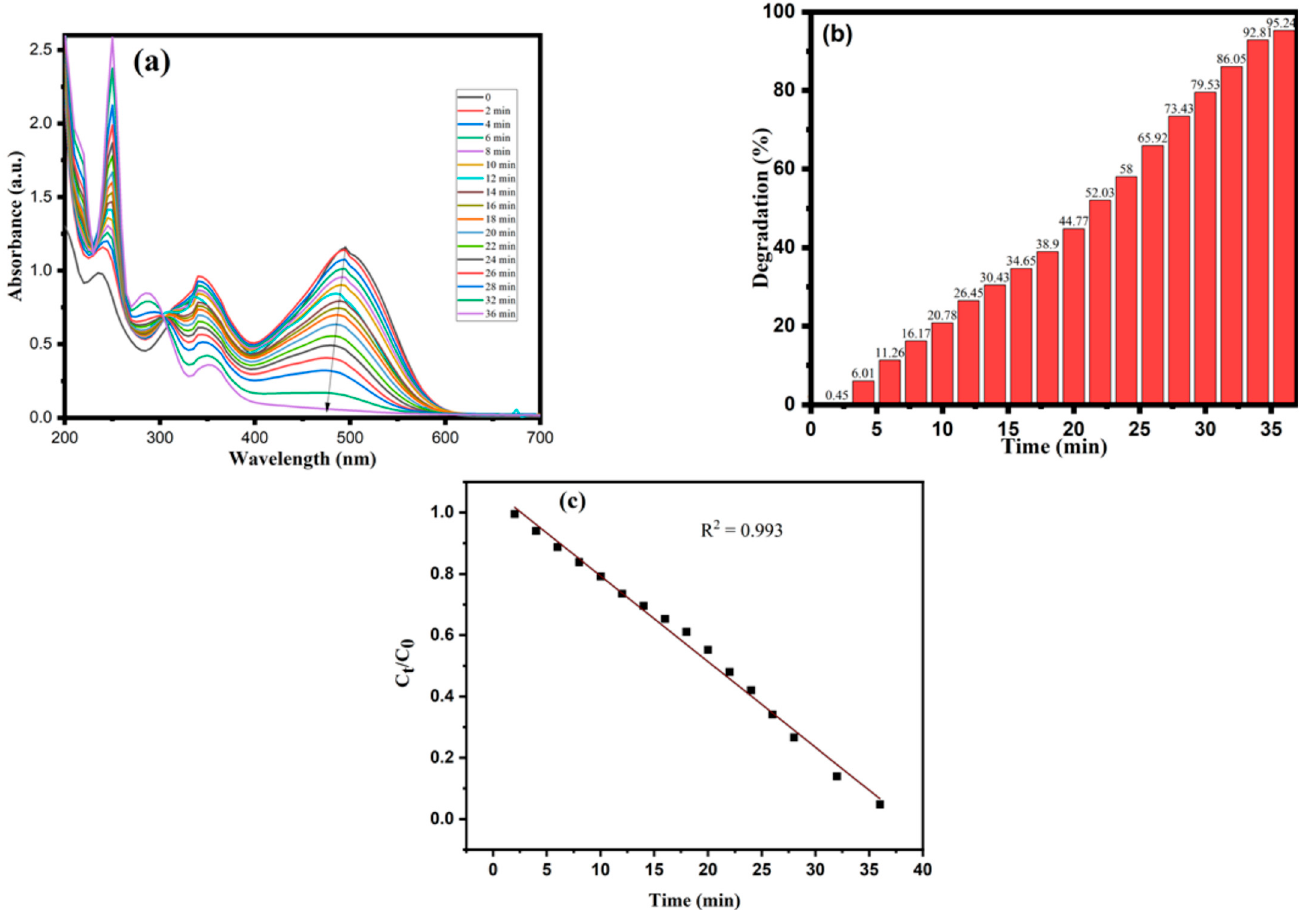
Figure 7. Results of CR dye degradation studies with CA-AgNPs ( a ) UV–Visible spectra, ( b ) Degra- dation %; ( c ) C t /C o vis Time graph.